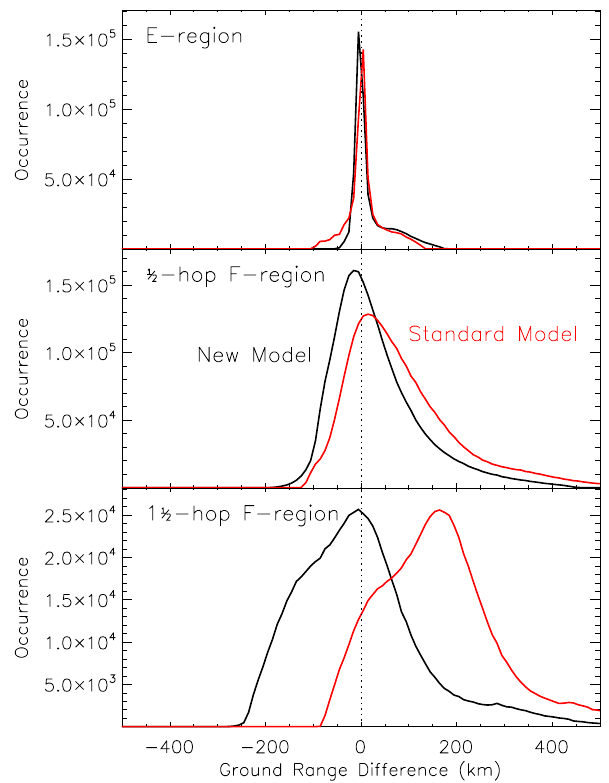
Fig. 13. Ground range difference distributions comparing the per- formance of the new empirical model (black distributions) and the standard SuperDARN model (red distributions). The distributions are determined by comparing all the measured ground range values from the Saskatoon beam 3 data set with the ground range values predicted by the models. The distributions for the 1 -hop E-region 2 - models use data below 790km range. The distributions for the 1 2 hop F-region models use data between 790 and 2130km range. The distributions for the 1 1 -hop F-region models use data above 2 2130km